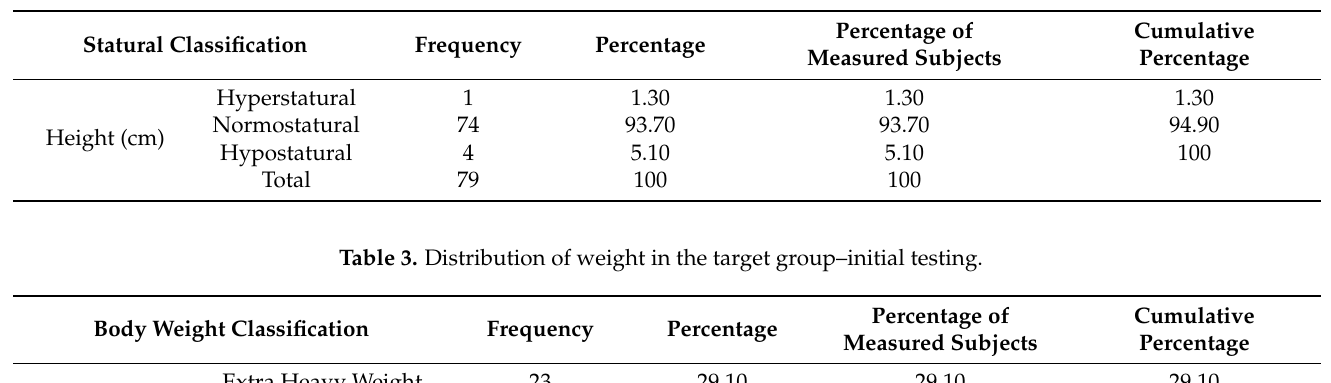
Table 2. Distribution of height in the target group–initial testing.